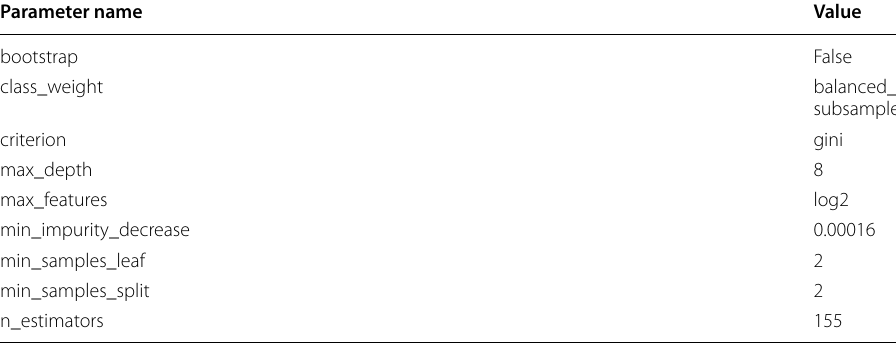
Table 67 Modes of RF tuned hyperparameter values for experiments with the information theft dataset